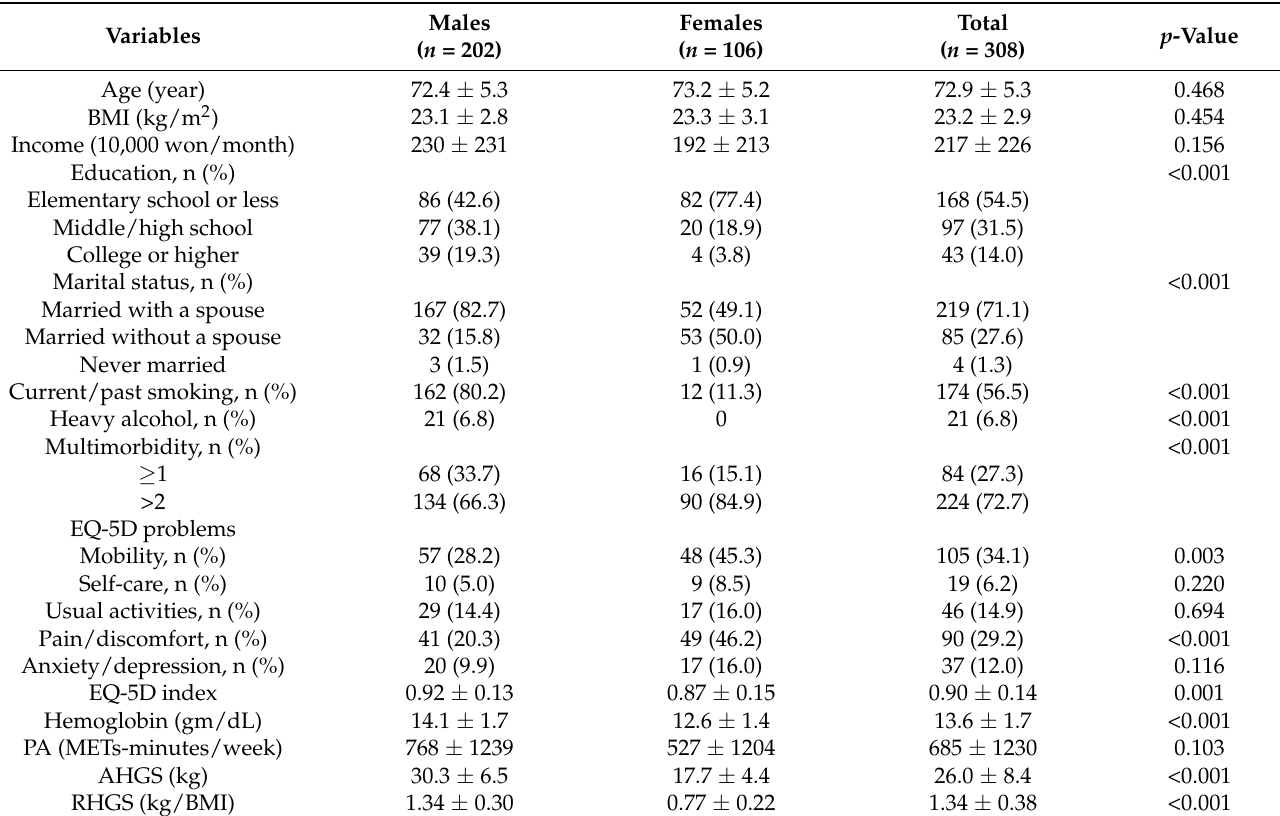
Table 1. Descriptive statistics of study participants by gender.